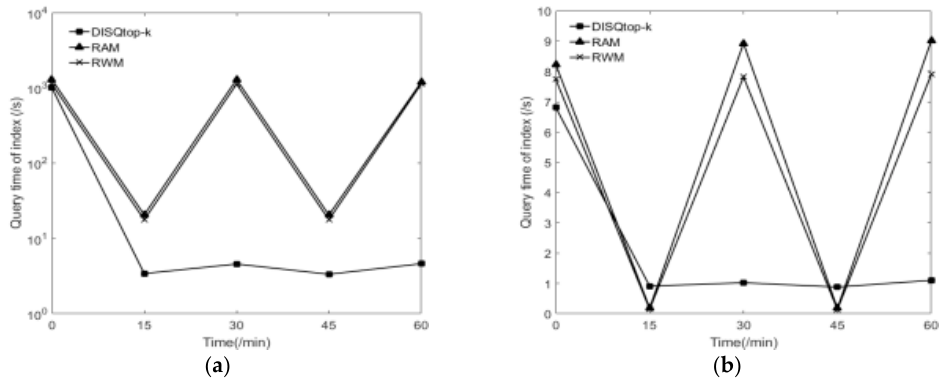
Figure 12. The comparison of the dynamic query efficiency. ( a ) Comparisons in the real dataset DBLP; ( b ) Comparisons in the synthetic dataset G 1 .